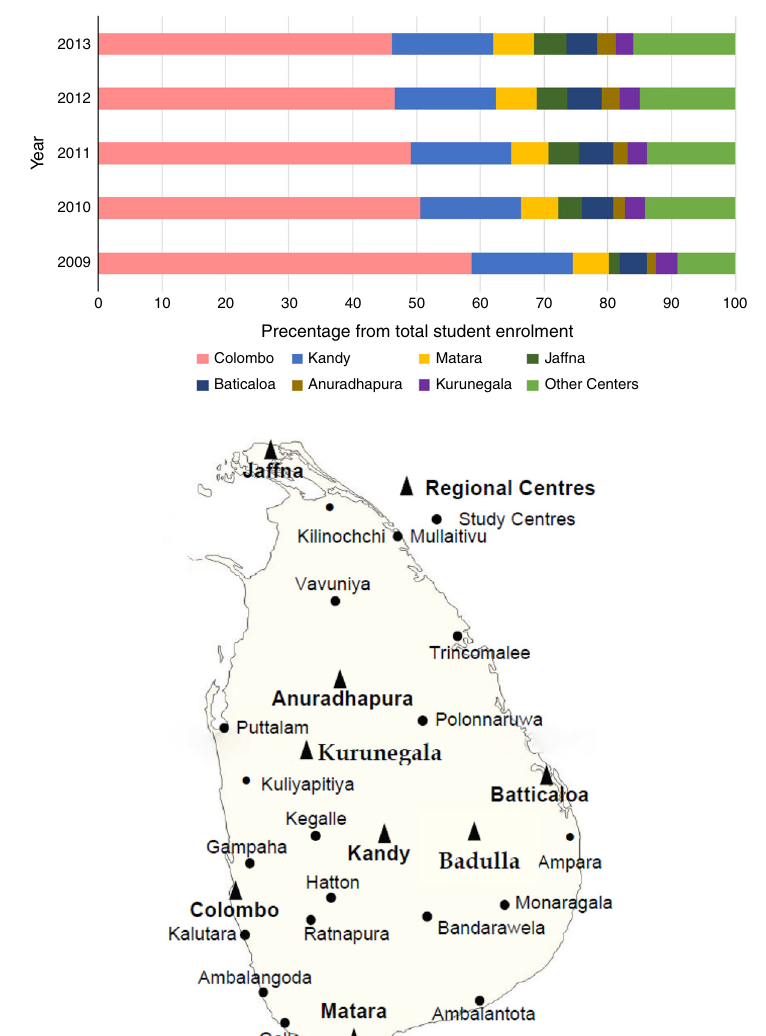
Figure 4. Regional and study centres of the